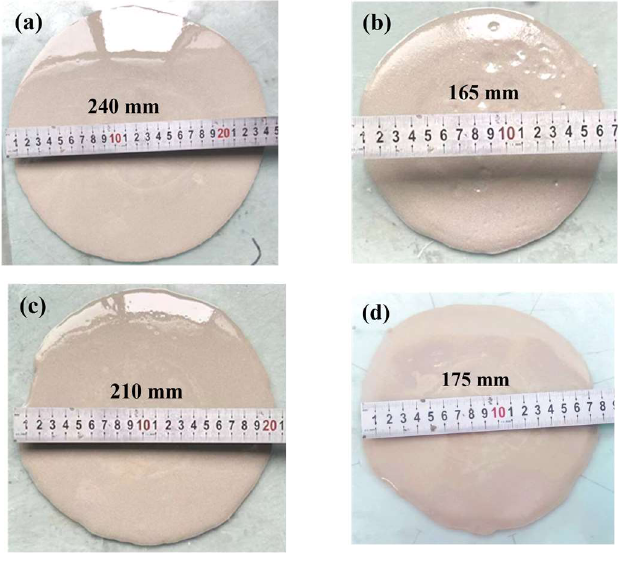
Figure 21. Flow state of slurry at 30 s with different alkali activator content: ( a ) NaOH: 2%; ( b ) NaOH: 5%; ( c ) Na 2 SiO 3 : 0%; ( d ) Na 2 SiO 3 :